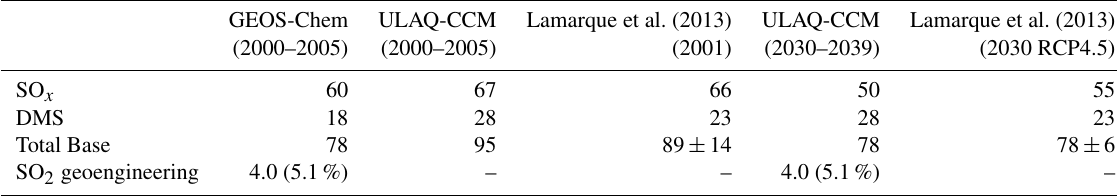
Table 3. Breakdown of global sulfur emission fluxes (TgSyr − 1